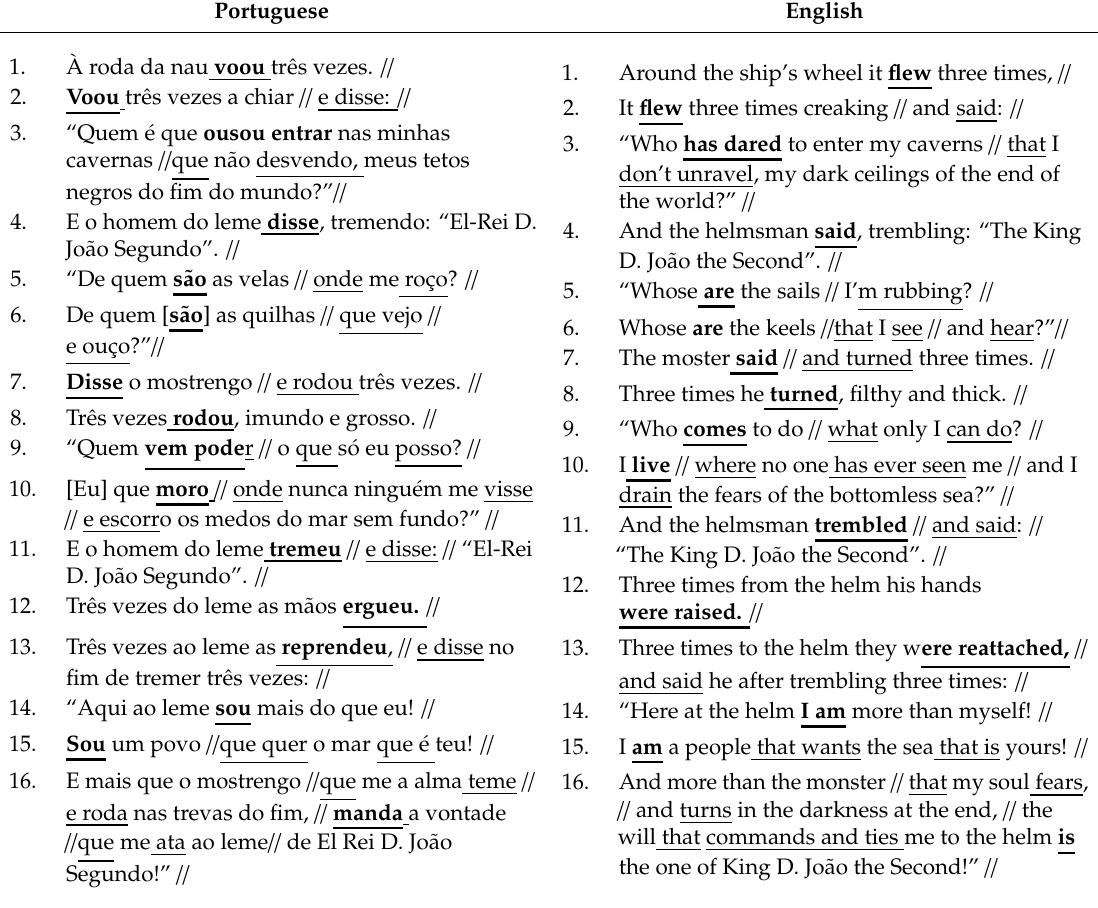
Figure A4. Stimulus 4—Pitch structure. Table A4. Stimulus 4—Transcription. Table A4. Stimulus